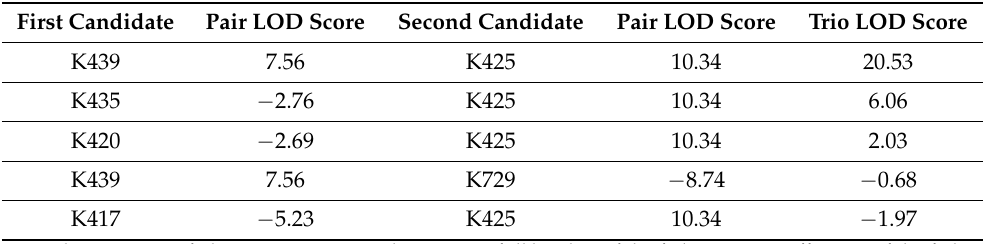
Table 2. The parentage assignment LOD scores for parent pairs (sex